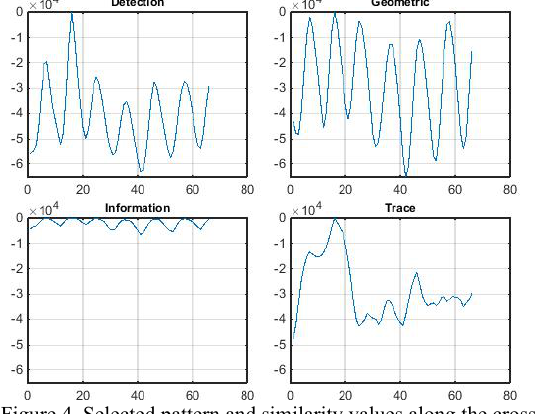
Figure 4. Selected pattern and similarity values along the cross section line For a detailed comparison, Figure 4 plots the similarity values of a slice through the pattern. The slice is marked as the red line in Figure 2. The target point is the intersection of the red